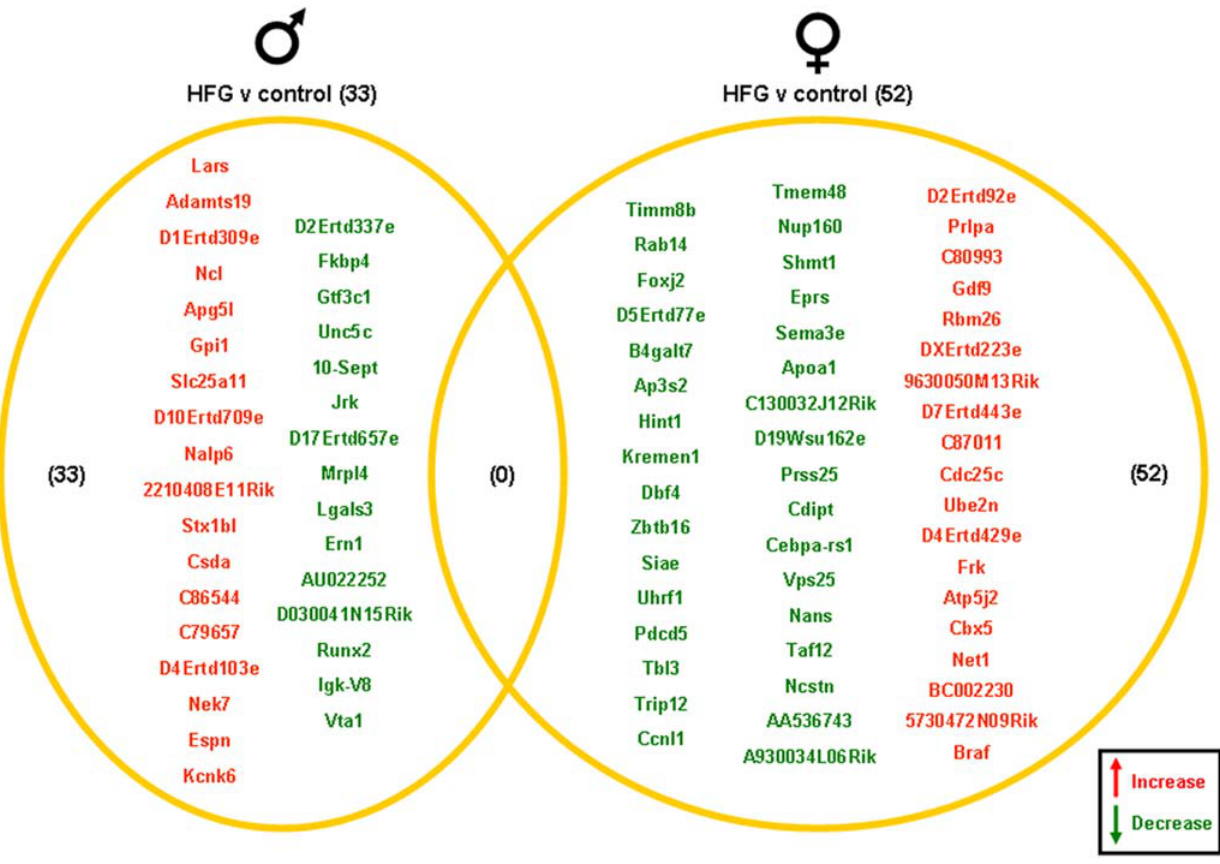
Figure 6. Gene changes in the gonads of male and female rats maintained on the HFG diet compared to the gonads of male and female rats maintained on a control ( adlibitum ) diet. Genes that were significantly up-regulated (red) or down-regulated (green) were clustered into a Venn diagram. There were 18 significantly up-regulated and 15 significantly down-regulated genes in the testes collected from HFG male rats compared to controls. Ovaries collected from HFG female rats showed 19 significantly up-regulated (red) and 33 significantly down- regulated (green) genes compared to controls. There were no common genes between male and female rats in this dietary group. Names of the significantly altered genes can be found in Table